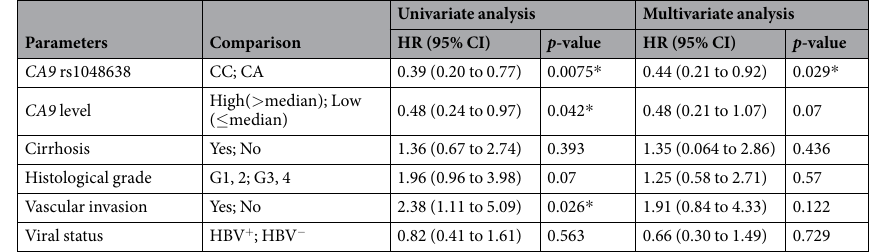
Table 2. Univariate and multivariate analyses of potential prognostic variables in 86 hepatocellular carcinoma patients. * Two-sided Cox proportional hazards regression using normal approximation. HBV, hepatitis B virus; HR, hazard ratio; CI, confidence